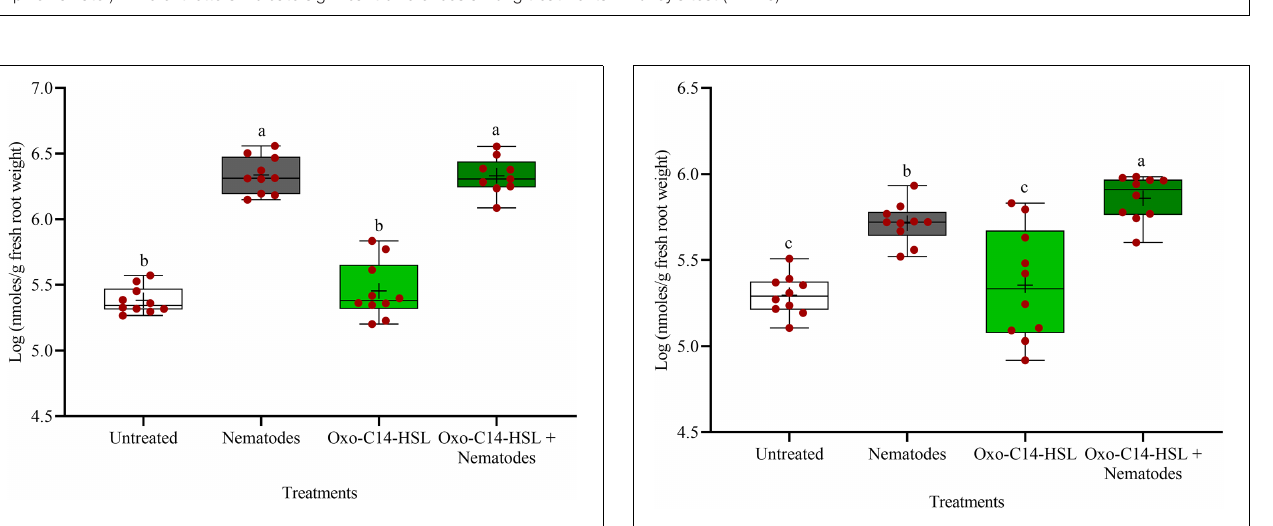
FIGURE 6 | Persistence of enhanced defense of plants against root invasion of Pratylenchus penetrans after removal of inducing agents (oxo-C14-HSL or PpNemawater). Different letters indicate significant differences among treatments in Tukey’s test ( n = 10).